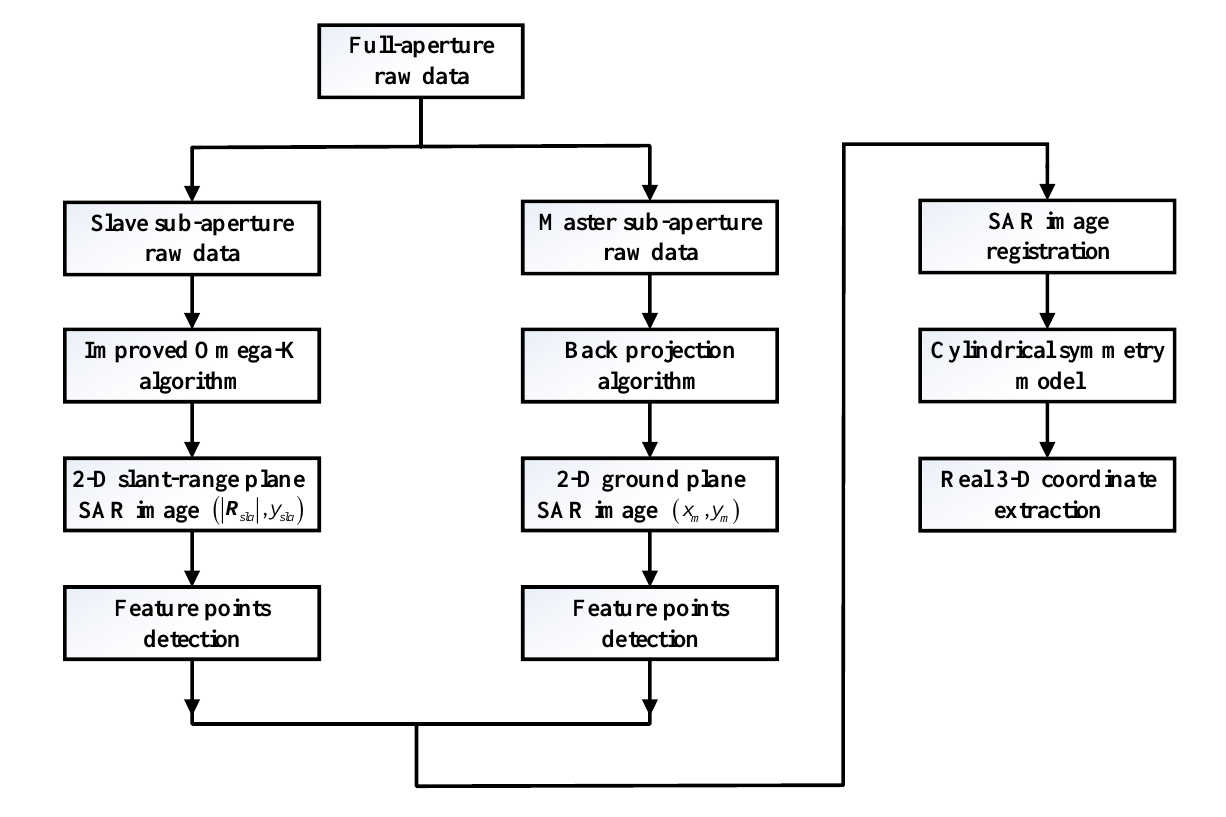
Figure 7. Flowchart of the proposed approach.